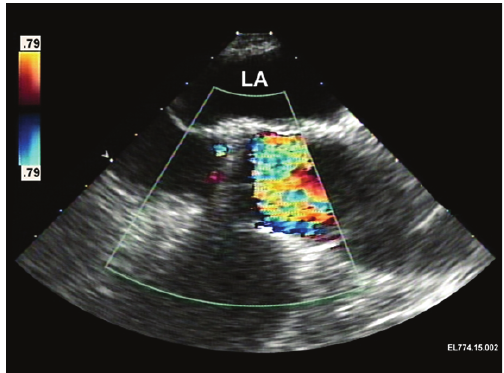
Figure 2: Intraoperative transesophageal echocardiographic view prior to replacement of the aortic valve prosthesis. This mides- ophageal aortic valve long axis view during systole demonstrates turbulent colorflow on the aortic side of the St. Jude prosthesis, suggestive of an elevated velocity and prosthetic gradient. The left atrium (LA) is also